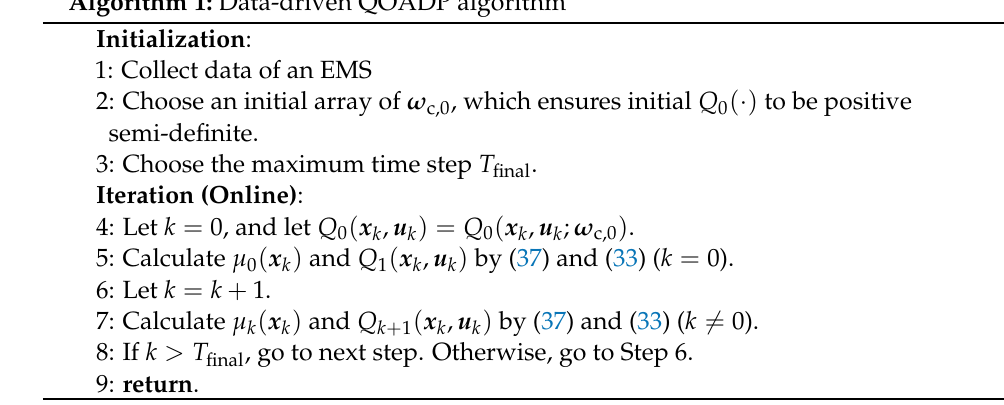
Algorithm 1: Data-driven QOADP